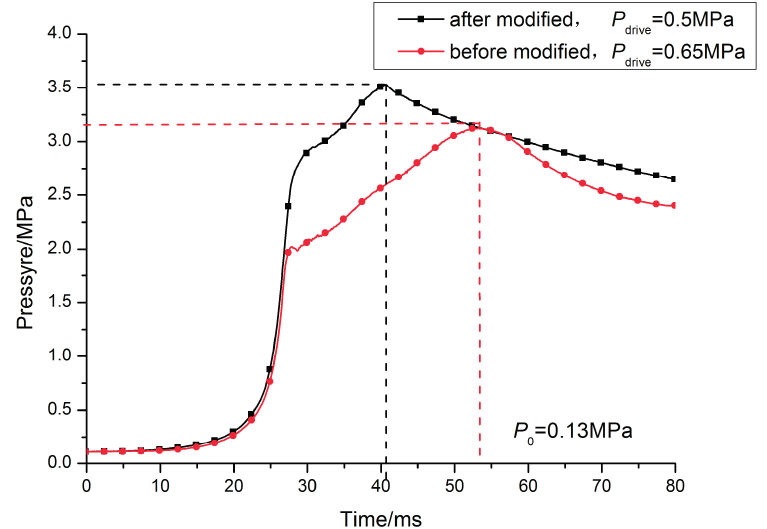
Figure 7. Effect of modification of the hydraulic